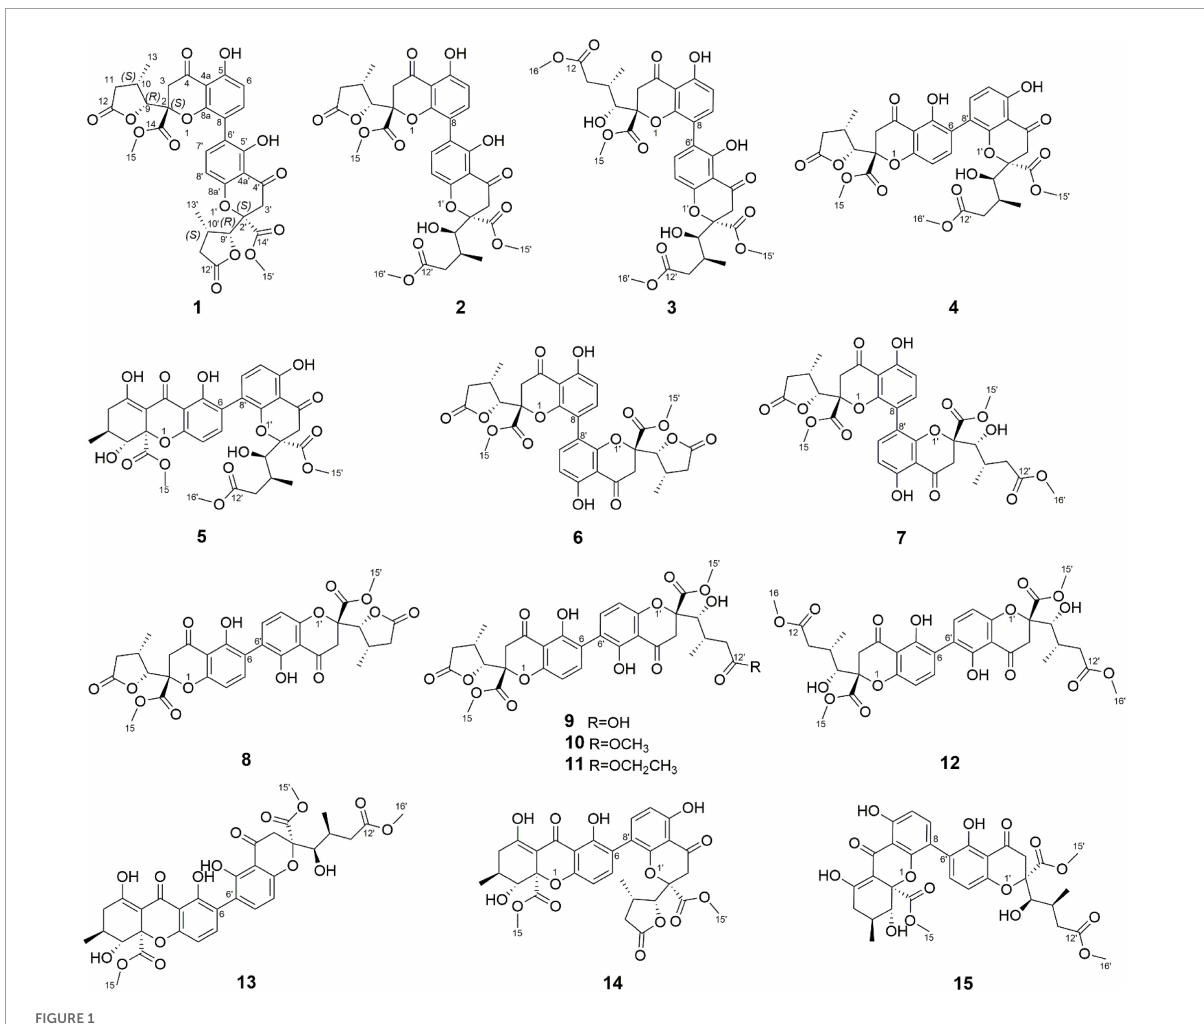
FIGURE1 Structures of Compounds 1 – 15